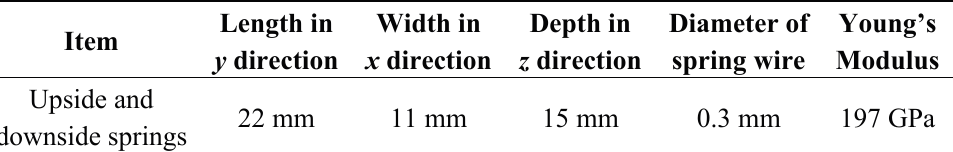
Figure 6. Variations of displacement of the prototype simulated using COMSOL at different car speeds: ( a ) 30 km/h, ( b ) 60 km/h, and ( c ) 100 km/h. Table 3. Parameters of the folded springs for the